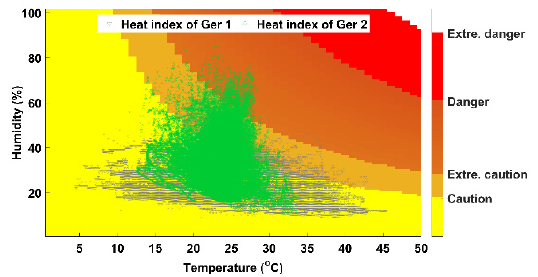
Figure 4. The indoor heat indices of the two experimental gers. The black triangular mark indicates the heat index of Ger 1, and the heat index of Ger 2 is presented by the green triangular mark.